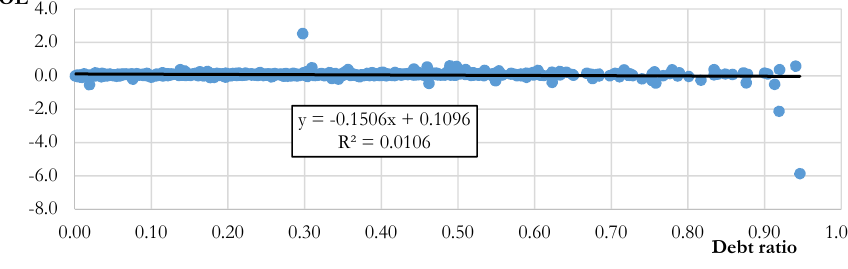
Fig. 3 – Relationship of ROE and debt ratio in the business sector A - Agriculture, fishery, and forestry. Source: Own investigation.